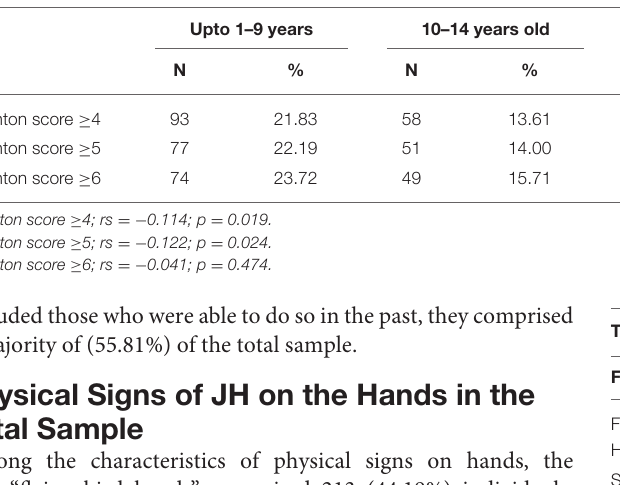
TABLE 3 | Absolute and percentage distribution of Beighton scores ≥ 4, ≥ 5, and ≥ 6 by age-group and in the total sample.